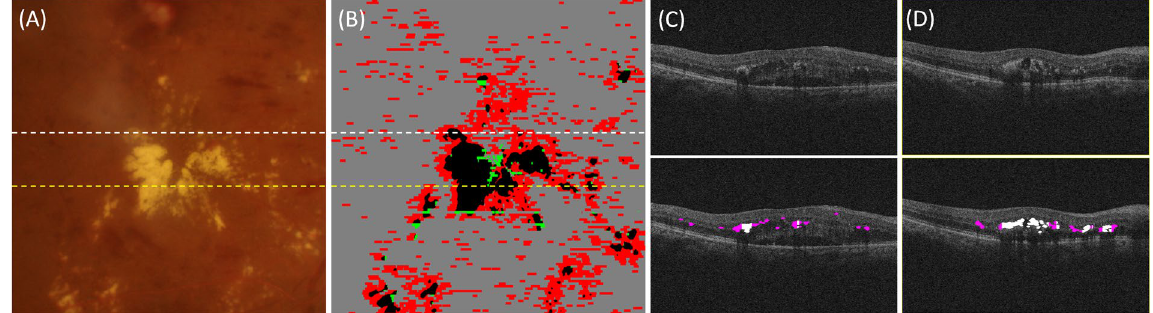
Figure 6. The combined analysis of SD OCT B-scan and aligned CFP. ( A ) The cropped CFP images, where hyper-reflective regions represent hard exudates. ( B ) The comparison of HE segmentation results on CFP and hyper-reflective foci results on SD OCT. The black regions are hard exudates measured by CFP and SD OCT. The green regions measured by CFP are hard exudates that are missed by SD OCT. The red regions represent hyper-reflective foci on SD OCT, where these foci could not be identified in the corresponding CFP. ( C ) and ( D ) SD OCT B-scan images correspond to the white and yellow dotted line, respectively, where the pink regions and the white regions are hyper-reflective foci and hard exudates, respectively.